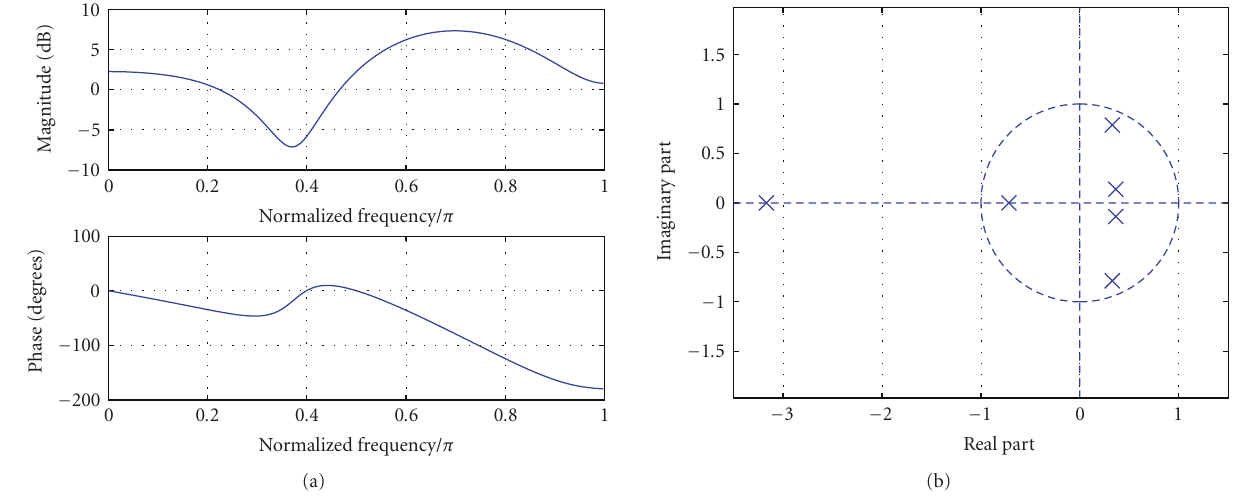
Figure 3: Example channel characteristics: (a) (top) frequency response, (a) (bottom) phase response, (b) and zeroes locations.